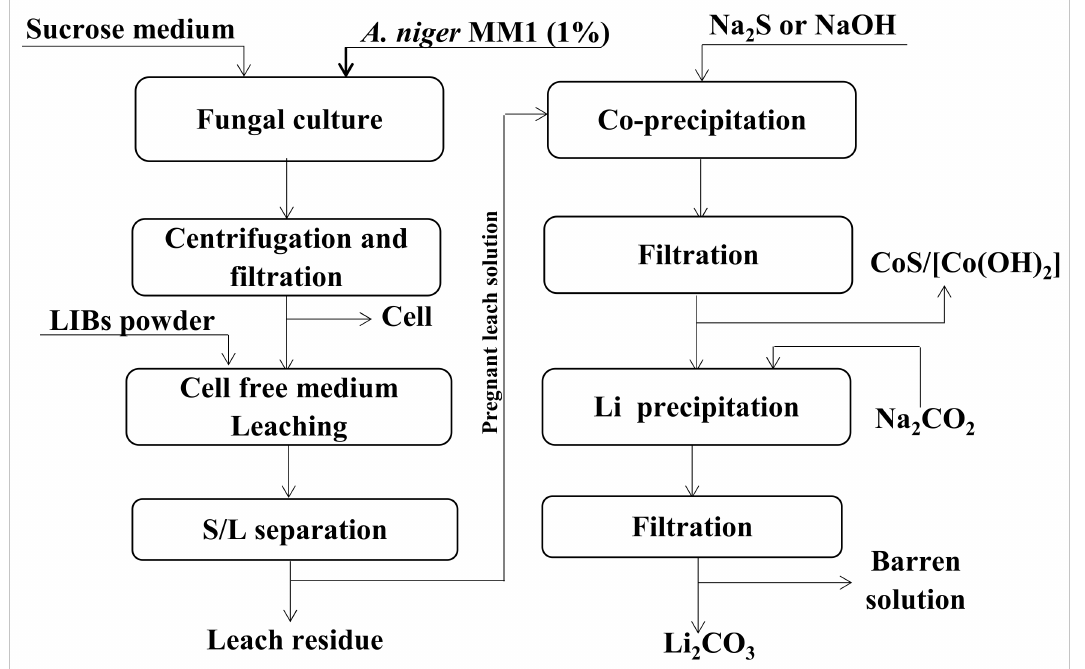
Figure 6. Bioleaching of LIBs with A. niger (drawn based on information collected from